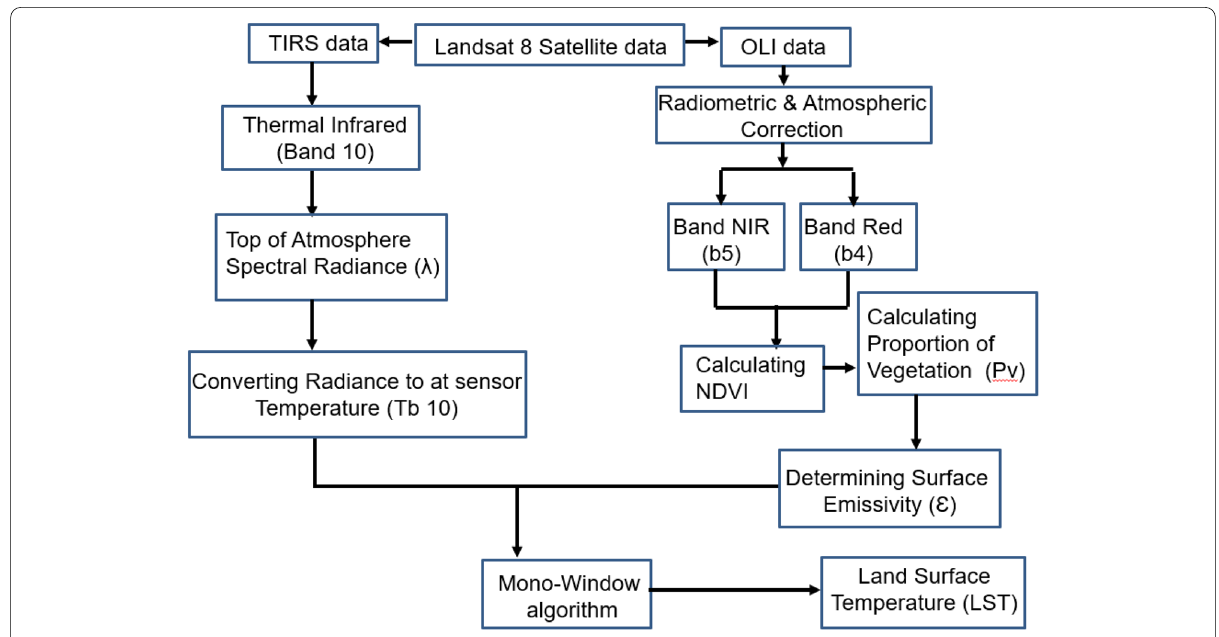
Fig. 5 Methodological flow chart of retrieving LST from Landsat 8 OLI